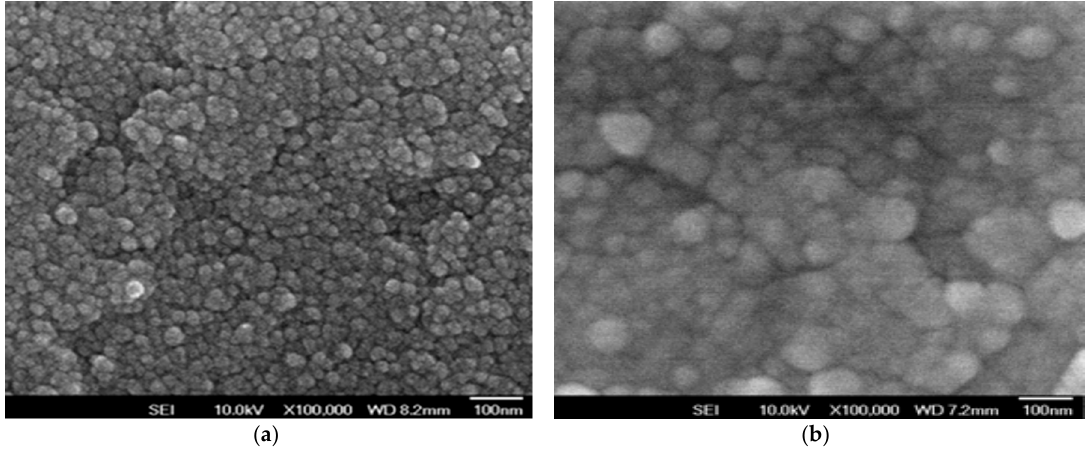
Figure 2. The SEM morphology of the neodymium oxide thin films for ( a ) 40%, and ( b ) 60% oxygen concentration parameters.